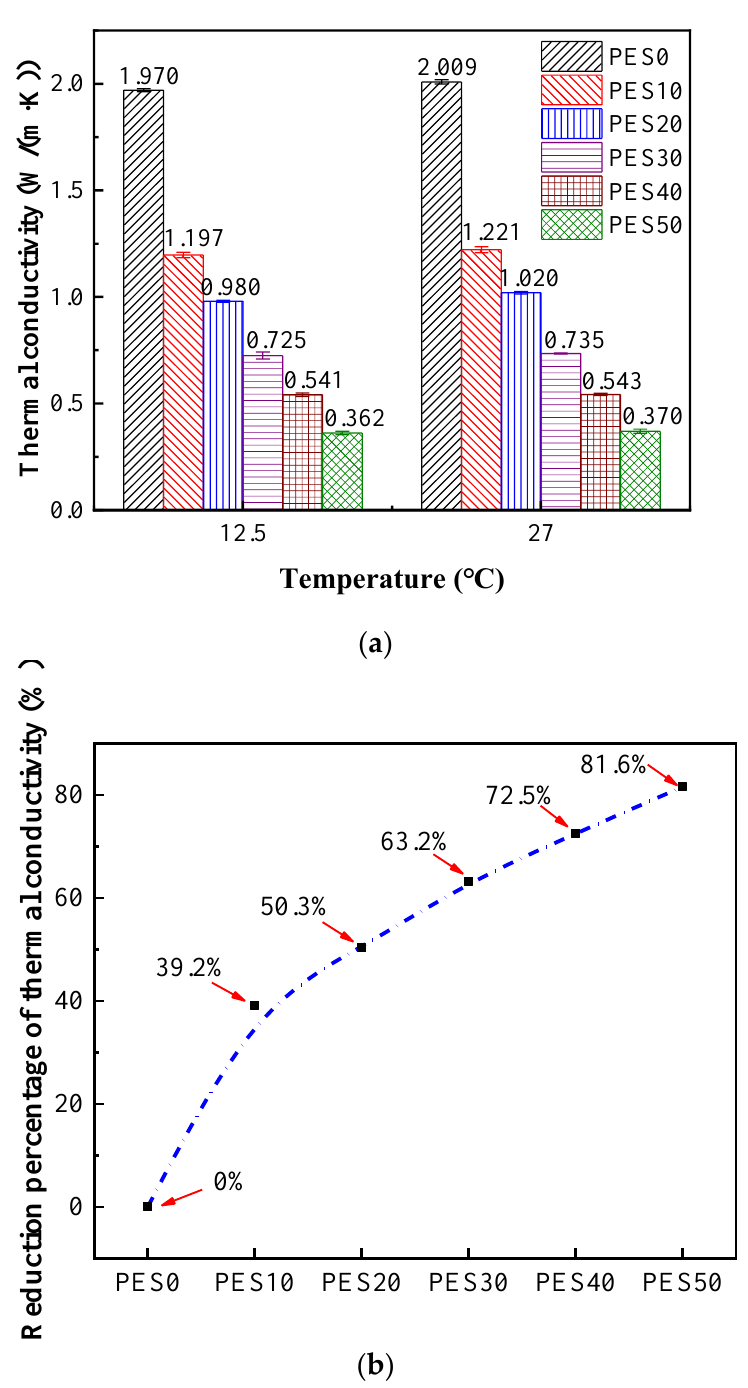
Figure 9. The thermal conductivities and reduction percentages of solid samples. ( a ) Samples of different SBS concentrations at 12.5 and 27 °C. The error bars are the standard deviation of the measurements (n = 3). ( b ) the reduction percentages of thermal conductivities compared to PES0 at 12.5 °C . Those results are the average values of different heat flows at the same qualitative temperature. Additionally, the error bars show the high repeatability of the experiments, considering the maximum deviation of thermal conductivities is less than 4.3%. As shown in the Figure 9b, the initial addition of 10 wt.% SBS reduces the thermal conductivity of PCM by 39.2% and the latter 10 wt.% SBS further reduces it by about 10%, and the slope of the curve noticeably